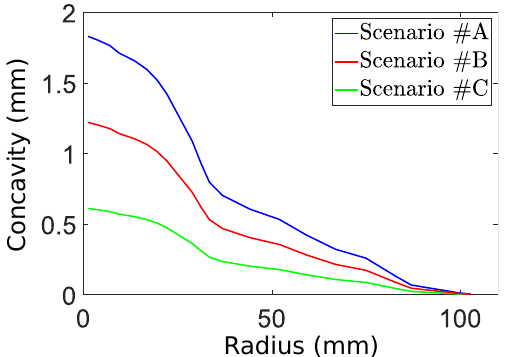
Figure 4. Concavities of the three different scenarios. Scenario #A (blue line) corresponds to a larger concavity compared to scenario #B, the concavity measured to the WMF pan with the robot (red line). Scenario #C (green line) corresponds to a flatter concavity compared to scenario